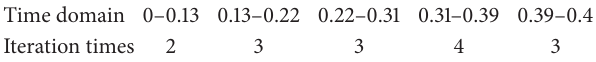
Table 1: Iteration times at different evolution time domain of the Burgers equation.